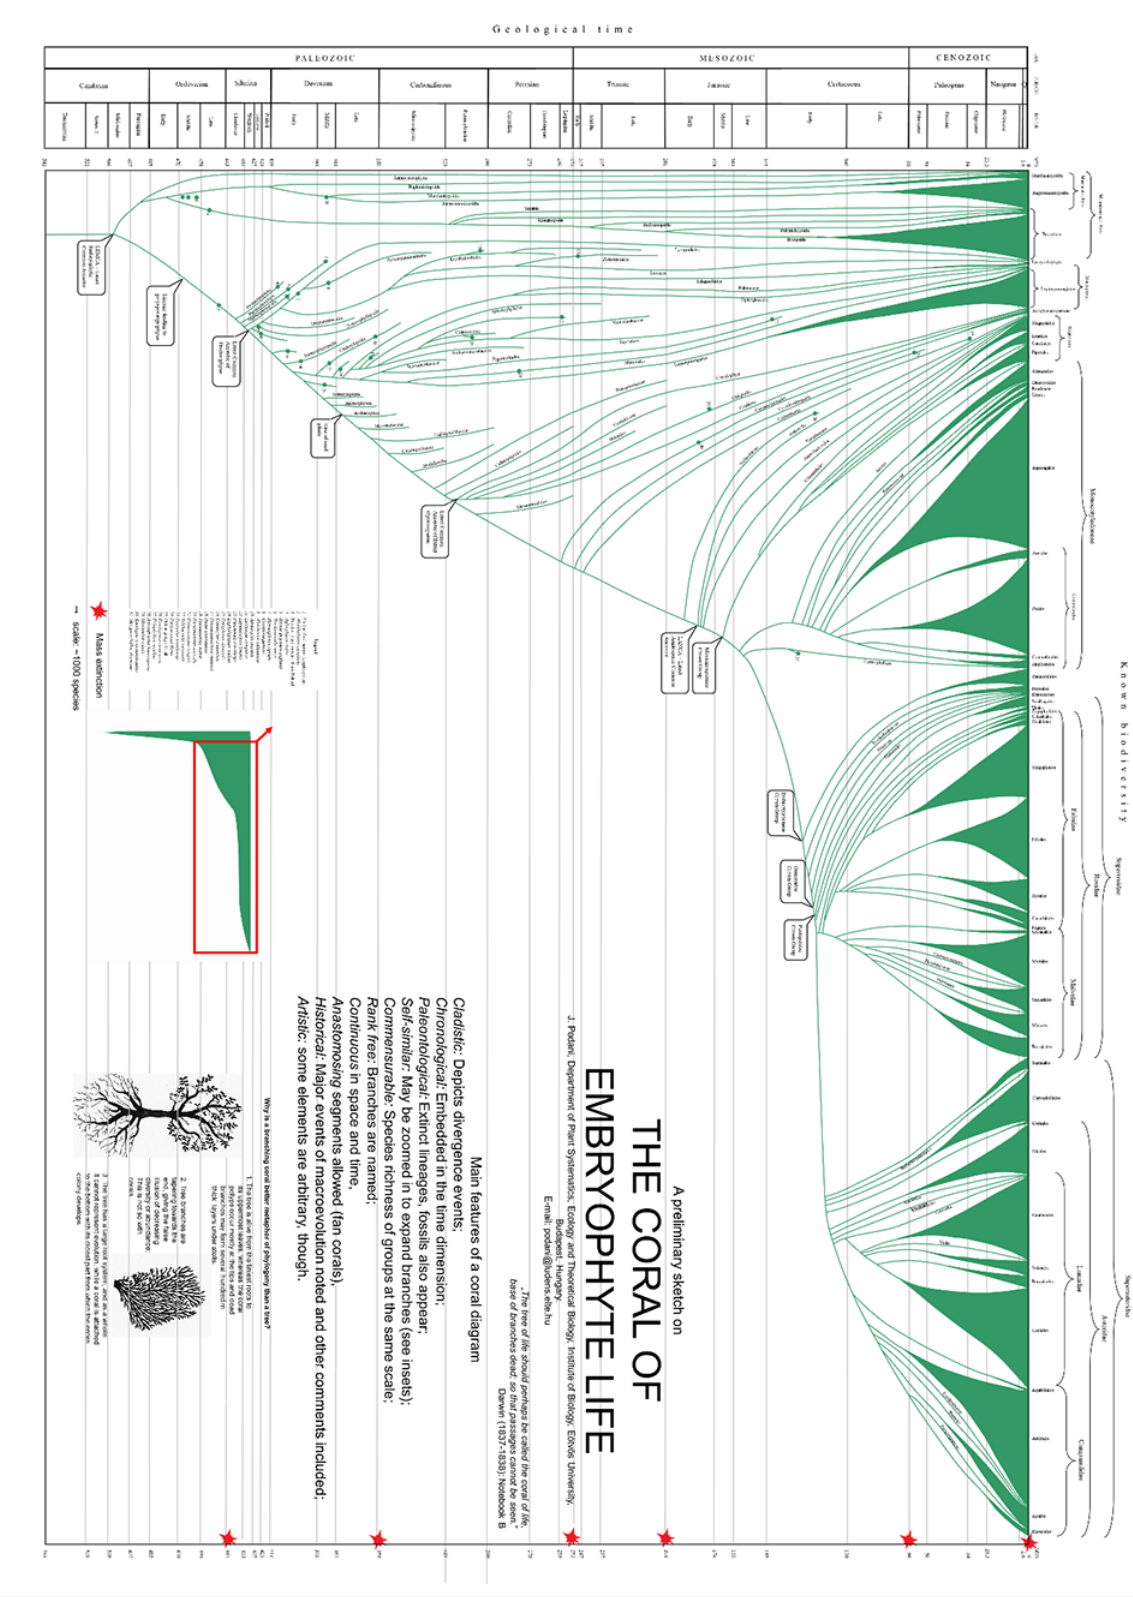
Figure 3 The Coral of Embryophytes. High-resolution image is supplied as Appendix S3.